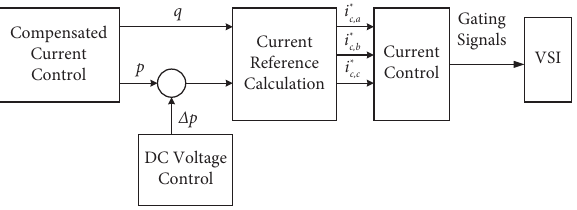
Figure 2: Te control confguration scheme of the APF.